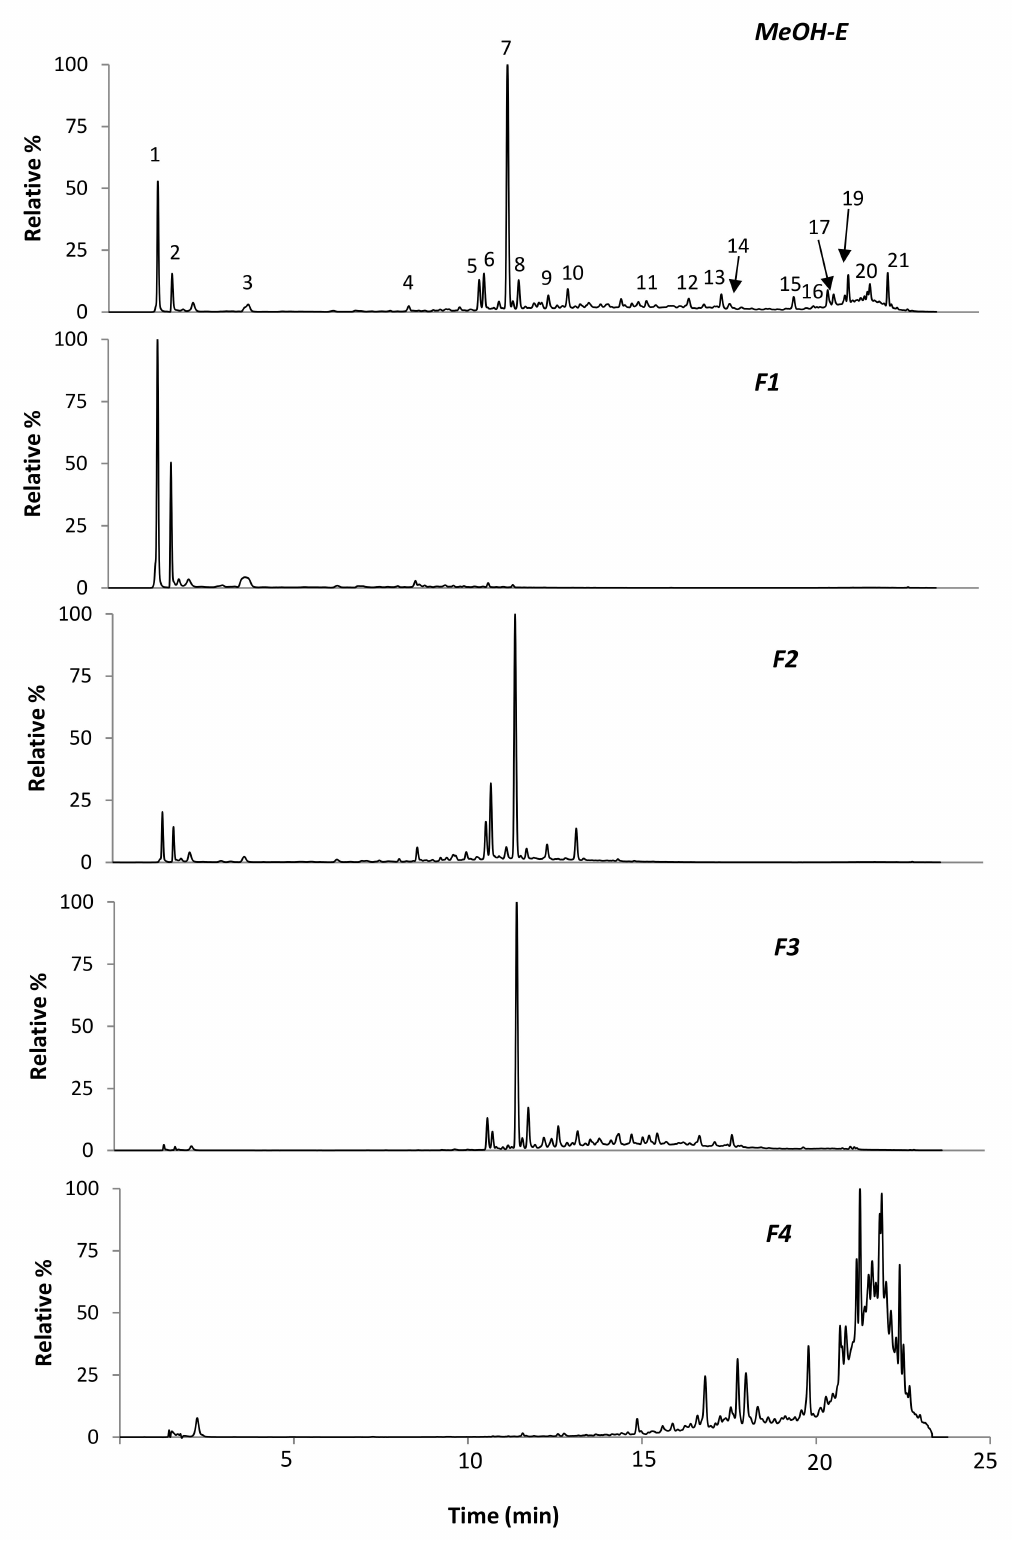
Figure 2. UV chromatographic profiles at 280 nm obtained by LC-DAD-ESI/MS n of R. raetam MeOH-E extract and the subsequent fractions F1, F2, F3 and F4. Numbers assigned to the peaks correspond to the peak numbers in Table